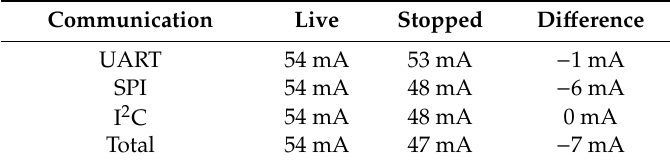
Table 3. Terminating Communication Protocol [UART, SPI, I2C]